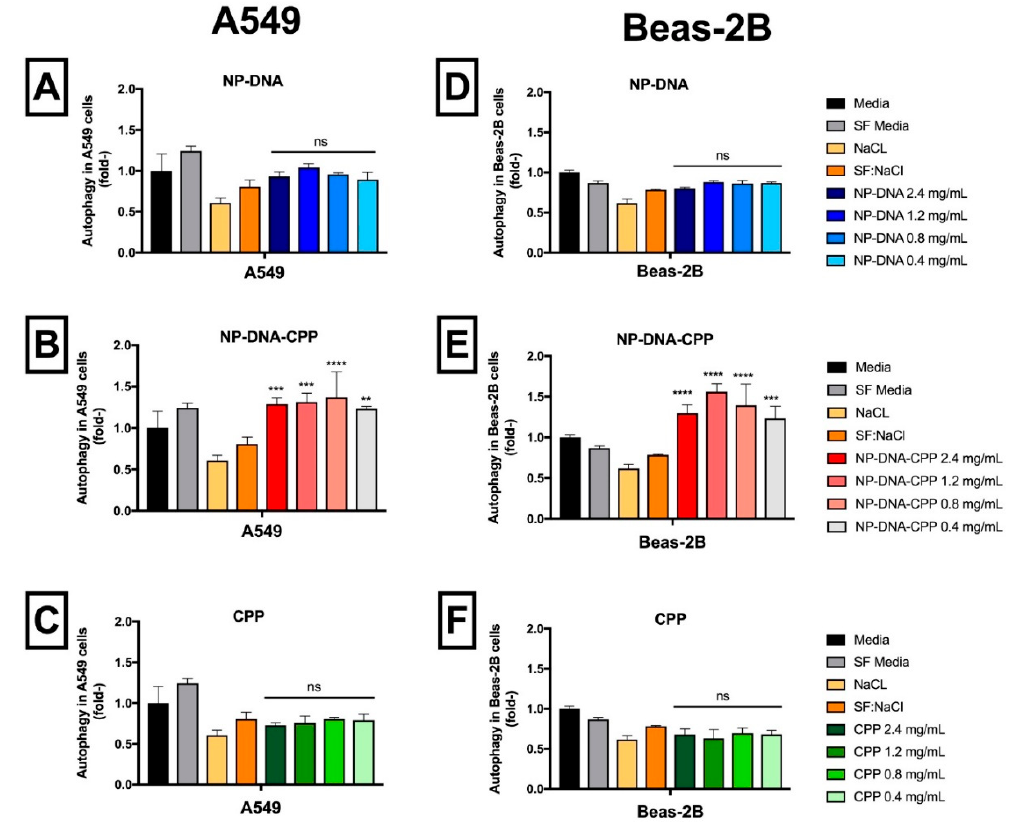
Figure 7. Autophagy in A549 ( A – C ) and Beas-2B ( D – F ) cell lines after exposed to NP–DNA ( A , D ), NP–DNA–CPP ( B , E ) and CPP alone ( C , F ). All treatments were compared to the SF:NaCl control using one-way ANOVA, followed by Tukey’s Test. ( n = 3; ns: not significant, ** p < 0.01; *** p < 0.001; *** p <